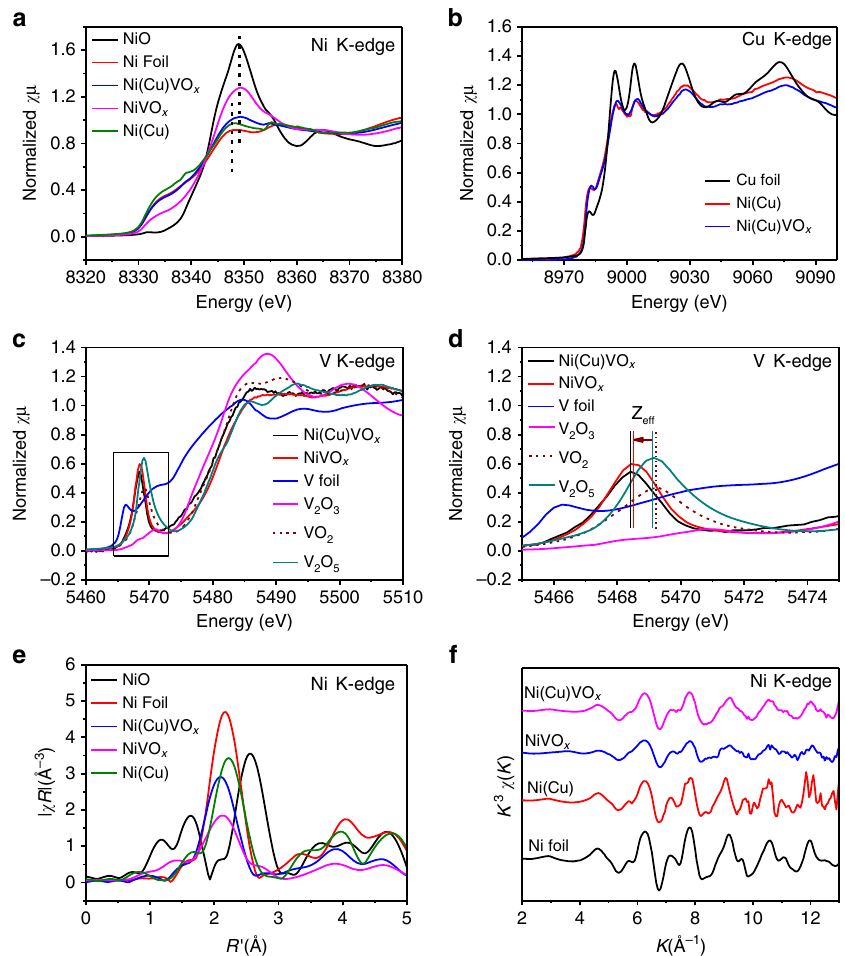
Fig. 3 X-ray absorption spectroscopy fi ne structures. a Ni and b Cu K-edge XAS. c , d K-edge XANES on V and the enlarged area marked in c Z eff = Effective nuclear charge. e FT-EXAFS and f EXAFS of the samples on Ni